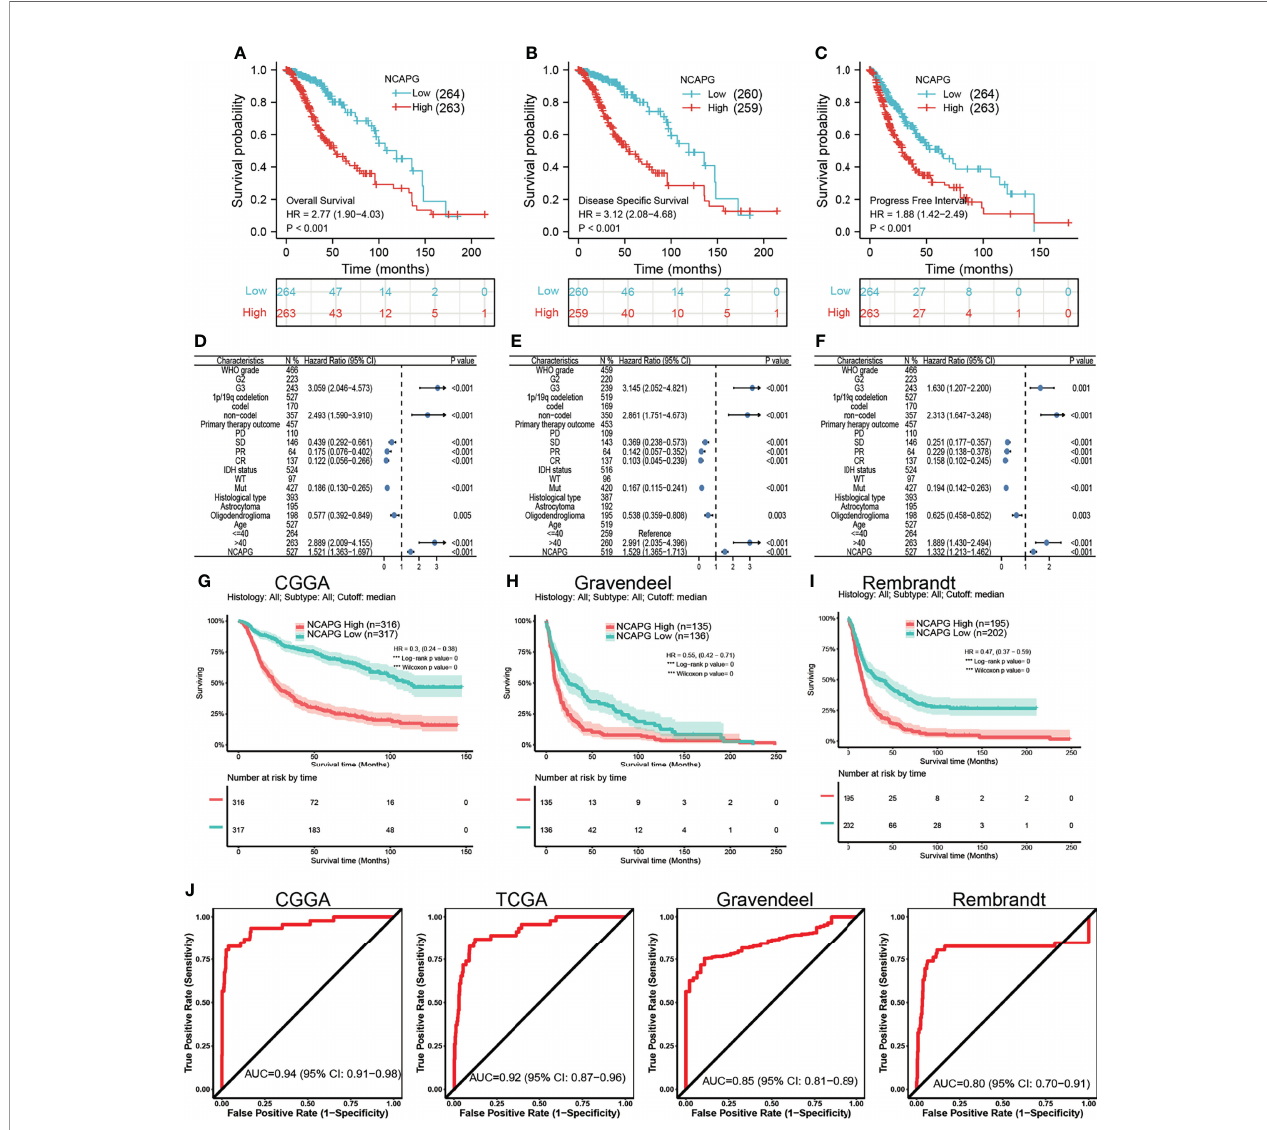
FIGURE 2 | The prognostic value of NCAPG in glioma. (A – C) The prognosis of NCAPG in glioma examine by TCGA databases. (D – F) The forest plot indicated that the prognosis in the presence of WHO grade, histology type, IDH mutation, 1p/19Q status for (D) OS, (E) DFS, and (F) PFS. (G – I) The prognosis of NCAPG in glioma determine by CGGA, Rembrandt, and Gravendeel databases. (J) ROC analysis showing the predictive value of NCAPG in glioma based on CGGA, TCGA- glioma, Gravendeel, and Rembrandt